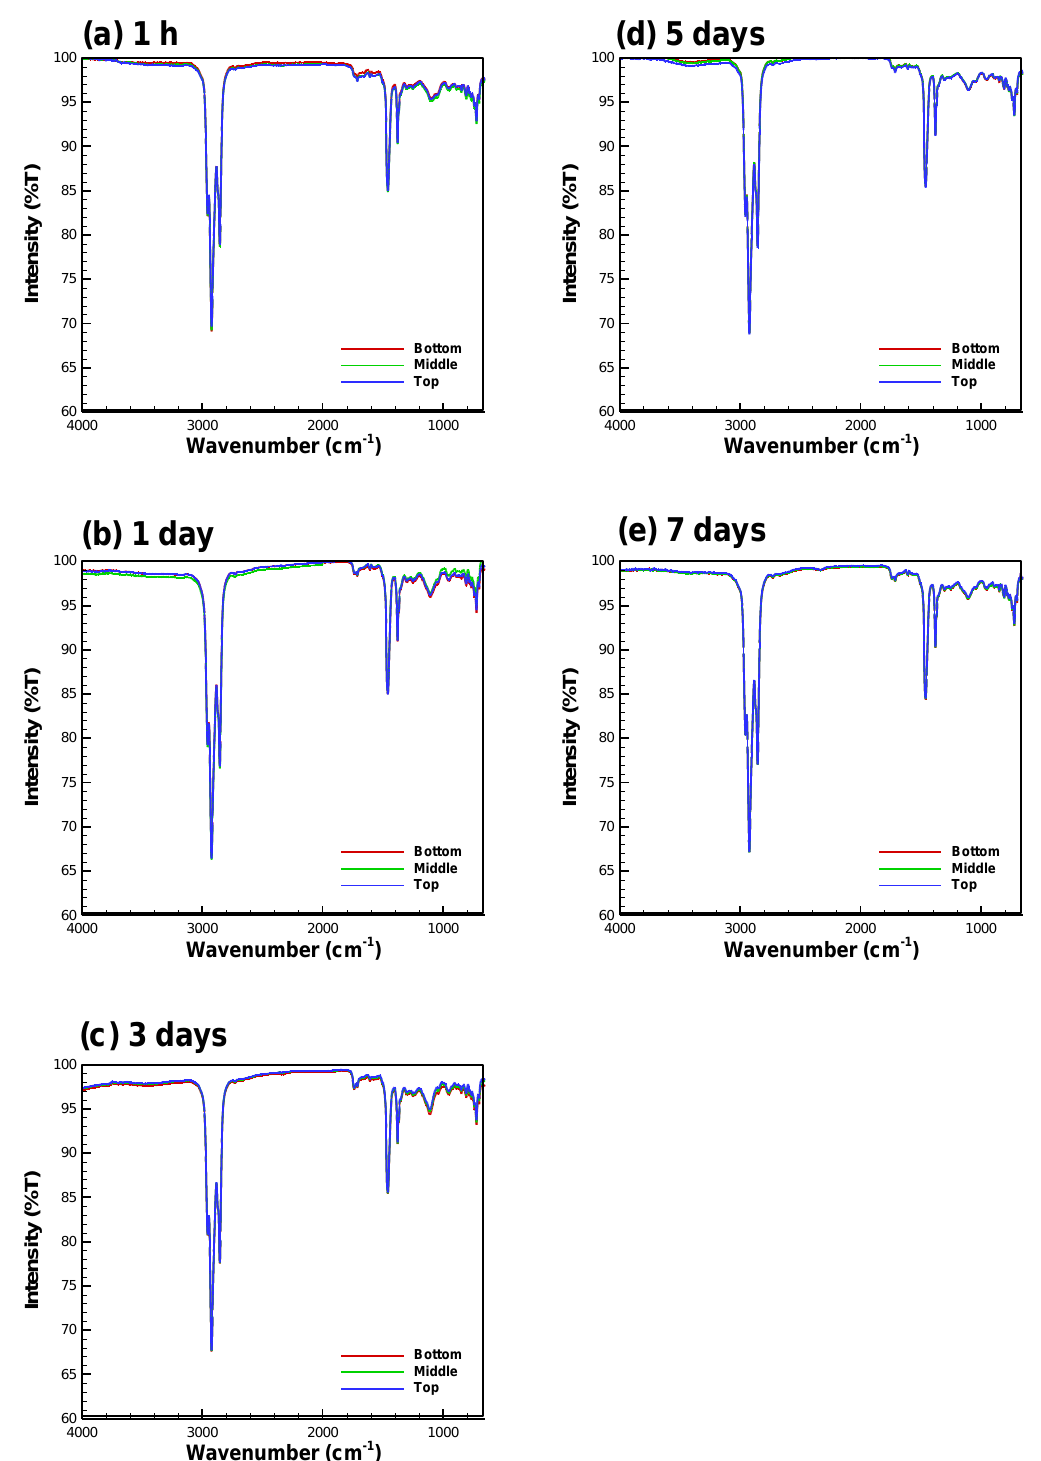
Figure 4. Fourier transform infrared spectroscopy (FTIR) spectra of emulsion (2 g bio-oil, B/E = 1) at three regions for ( a ) 1 h, ( b ) 1 day, ( c ) 3 days, ( d ) 5 days, and ( e ) 7 days.